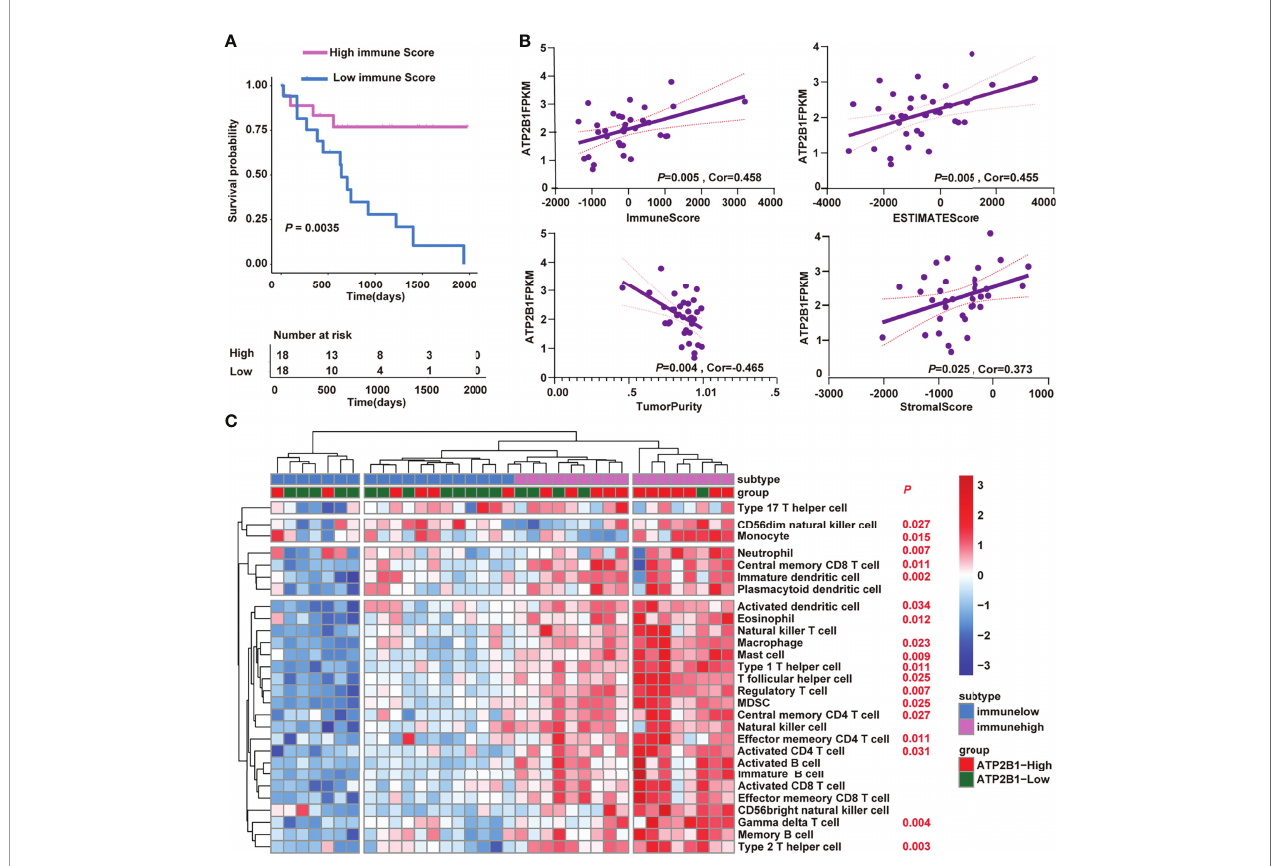
FIGURE 4 | ATP2B1 remodeling the tumor immune microenvironment. (A) Kaplan – Meier curves of the correlation of immune score with the prognosis of overall survival; (B) Correlation between ATP2B1 expression and the tumor immune microenvironment; (C) Differences of 28 immune cells in the high and low ATP2B1 expression